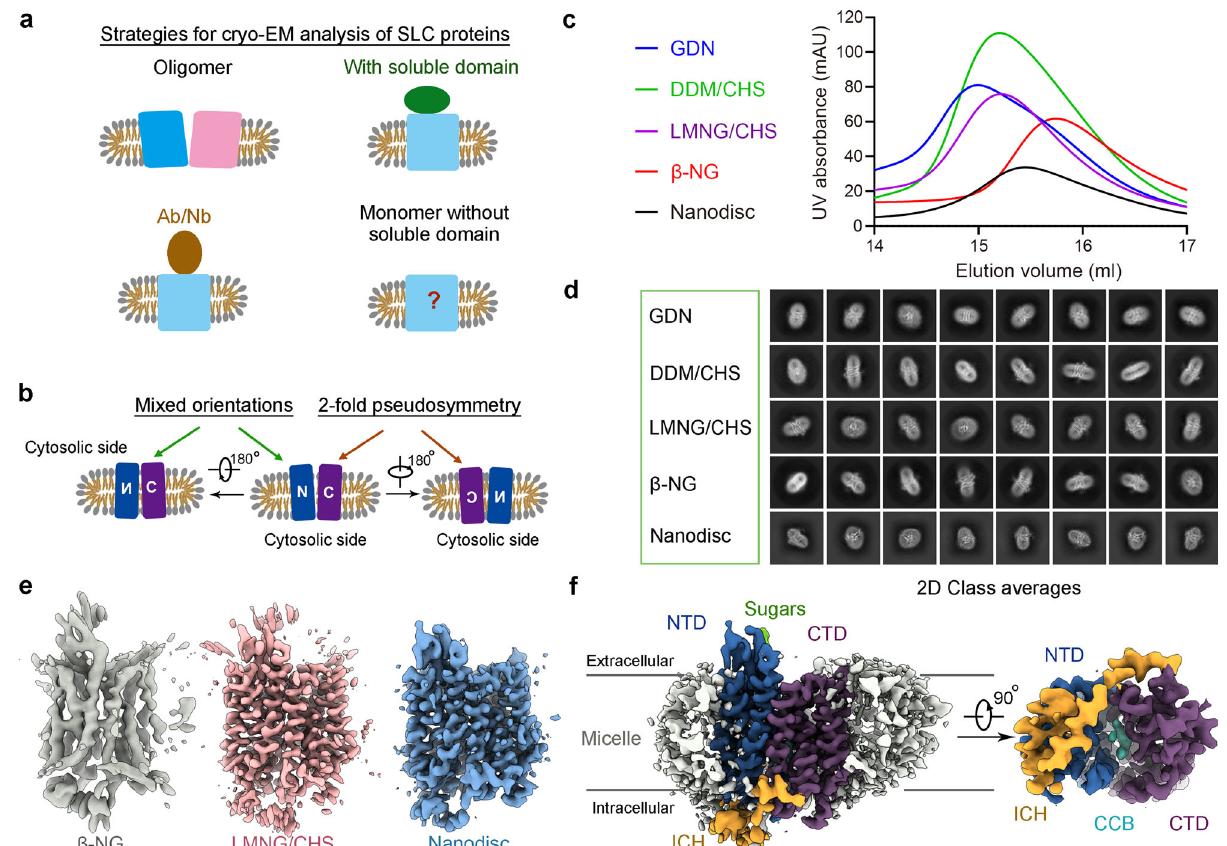
Fig. 1 Structural determination of human GLUT4. a General strategies for structural resolution of solute carriers (SLCs) using single particle cryo-EM. While homo-oligomeric SLCs are convenient targets for cryo-EM analysis, relatively rigid soluble domains, either intrinsic to the protein, or binders like antibodies (Ab) or nanobodies (Nb), are usually required to increase the size of the protein for cryo-EM imaging. There has been no report on the cryo-EM structure of monomeric SLCs with transmembrane domain only. b The two-fold pseudo symmetry of monomeric major facilitator superfamily (MFS) transporters poses another tier of technical challenge for solving their cryo-EM structures. A canonical MFS fold contains 12 transmembrane helices (TMs) organized to an amino terminal domain (NTD) and a C-terminal domain (CTD), which exhibit a two-fold pseudo symmetry around an axis that is perpendicular to the membrane plane. The lack of distinctive soluble domain and the pseudo symmetry imposes serious challenges for discriminating the orientations of the proteins embedded in the disc-like micelles or nanodiscs. c Detergent screening for optimal conditions for cryo-EM analysis of human GLUT4. To reduce the impact of the detergent micelles or nanodiscs, we screened for detergents that could yield smaller micelles. Shown here are overlaid SEC pro fi les of GLUT4 puri fi ed in the presence of 0.02% (w/v) GDN, 0.02% (w/v) DDM plus 0.002% (w/v) CHS, 0.01% (w/v) LMNG plus 0.001% (w/ v) CHS, 0.1% (w/v) β -NG, and nanodiscs. Source data are provided. d Representative 2D class averages of GLUT4 in indicated detergents and nanodiscs. TM features are evident for GLUT4 in LMNG/CHS, β -NG, and nanodiscs. e Cryo-EM structural analysis of GLUT4. GLUT4 puri fi ed in β -NG gave rise to a decent initial reference and the 3D EM reconstruction was re fi ned to 4.1 Å resolution. 3D EM reconstructions of GLUT4 in LMNG/CHS and nanodisc both reached higher resolutions to 3.3 Å. f Overall cryo-EM map of GLUT4 in a nanodisc. The density is domain colored, blue for the NTD, purple for the CTD, yellow for the intracellular helical (ICH) domain, and gray for the micelle. All density and structure fi gures were prepared in ChimeraX 52